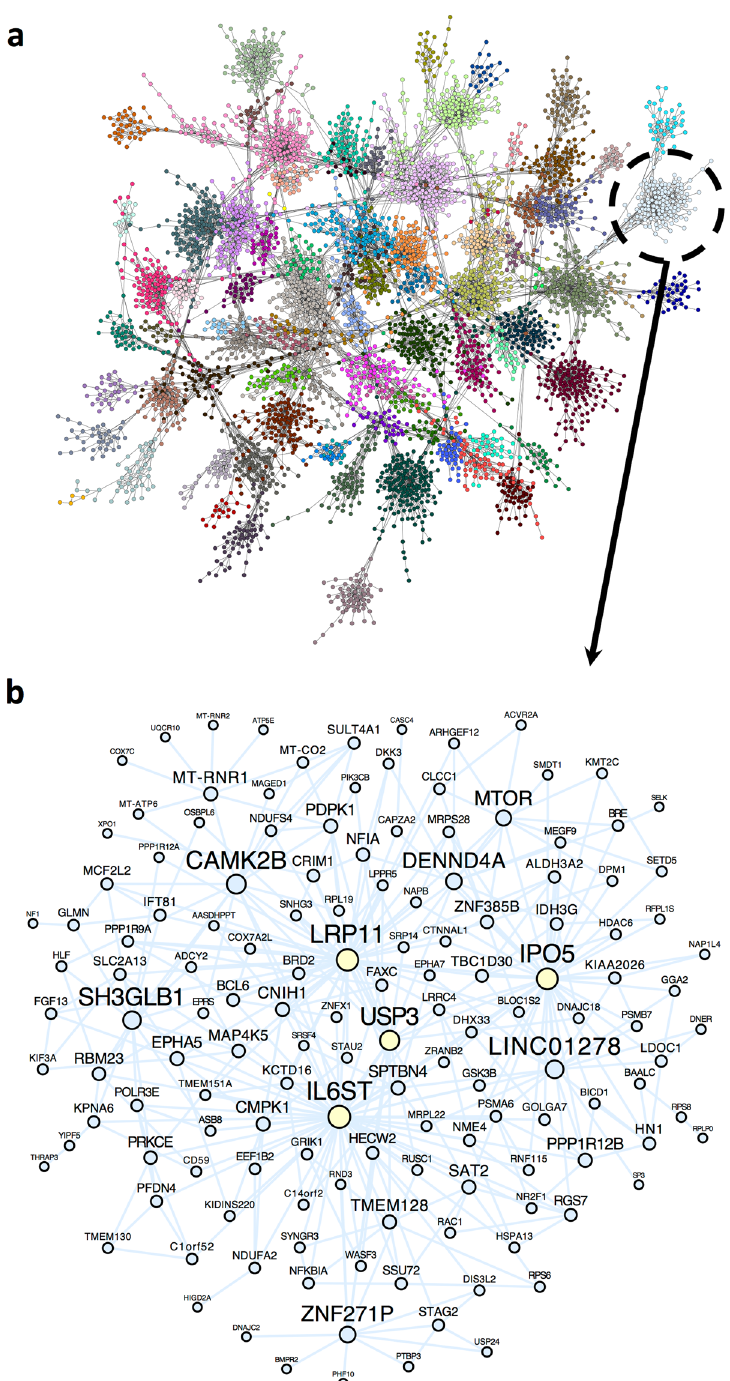
Figure 8. Multiscale networks identified within neurons contain neuron-specific modules. ( a ) Multiscale network modules identified using MEGENA in the Darmanis et al . human neuron-annotated RNA-seq samples. Dots represent genes while lines represent network connections, and dots are colored by their presence in one of several modules. (b) Zoomed-in gene-level network for the genes in Module #57, which is significantly enriched in the GO term “neurotrophin TRK receptor signaling